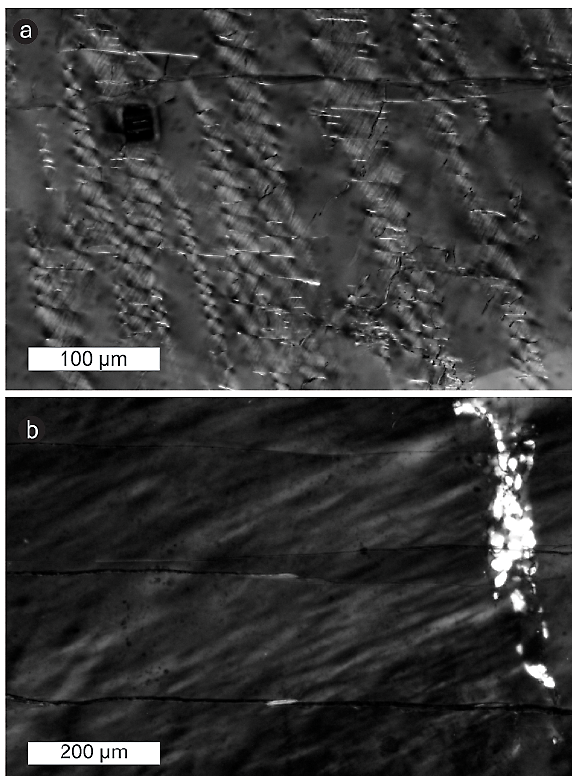
Fig. 11. Polarized light micrographs showing quartz microstructure after (a) “kick” experiment CR1-3 and (b) “kick and creep” experi- ment CR1-17. Note the different scale bar, which is chosen because of different characteristic wavelength of these microstructures. Mi- crofabrics corresponding to (a) will not be observed in metamorphic rocks due to modification during prolonged cooling and exhuma- tion history. Microfabrics depicted in (b) are similar to those found in exhumed metamorphic rocks (cf. Fig. 10) and indicate a stage of high-stress deformation in the low-temperature plasticity field, probably related to large earthquakes (see